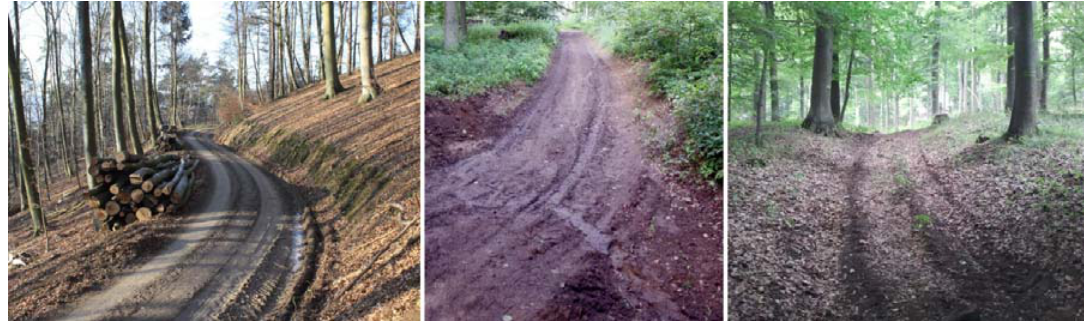
Figure 3. Exemplary road surfaces: ( left ) fortified road; ( middle ) unfortified road; and ( right ) skid trail.